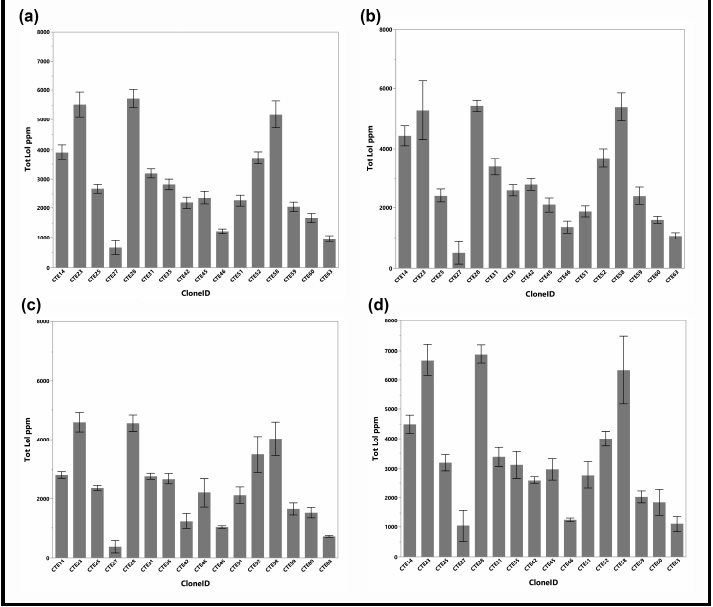
Figure 3. Seed head loline (Total lol) alkaloid levels in 16 CTE tall fescue clones ( a ) averaged over three years of study and for ( b ) 2017, ( c ) 2018 and ( d ) 2019 individually. Data are means +/ − 1 s.e.